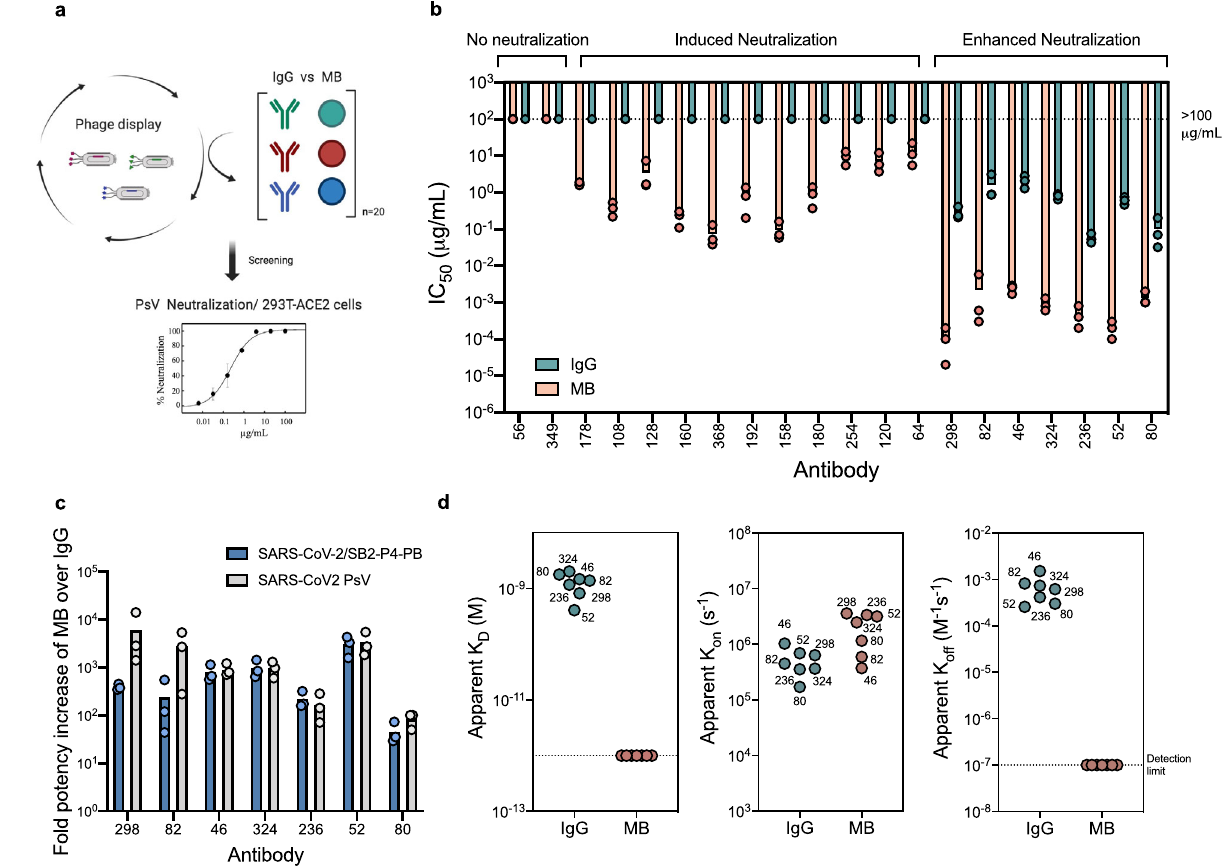
Fig. 4 The Multabody enhances the potency of human mAbs from phage display. a Work fl ow for the identi fi cation of potent anti-SARS-CoV-2 neutralizers using the MB technology. Created with Biorender. b Comparison of neutralization potency between IgGs (cyan) and MBs (pink) that display the same human Fab sequences derived from phage display. c IC 50 values fold increase upon multimerization. d Apparent af fi nity ( K D ), association ( k on ), and dissociation ( k off ) rates of the most potent neutralizing MBs (pink) compared to their IgG counterparts (cyan) for binding the SARS-CoV-2 S protein. Three biological replicates and their mean are shown for IC 50 values in ( b ) and ( c ). Source data of panels b – d are provided as a Source Data fi